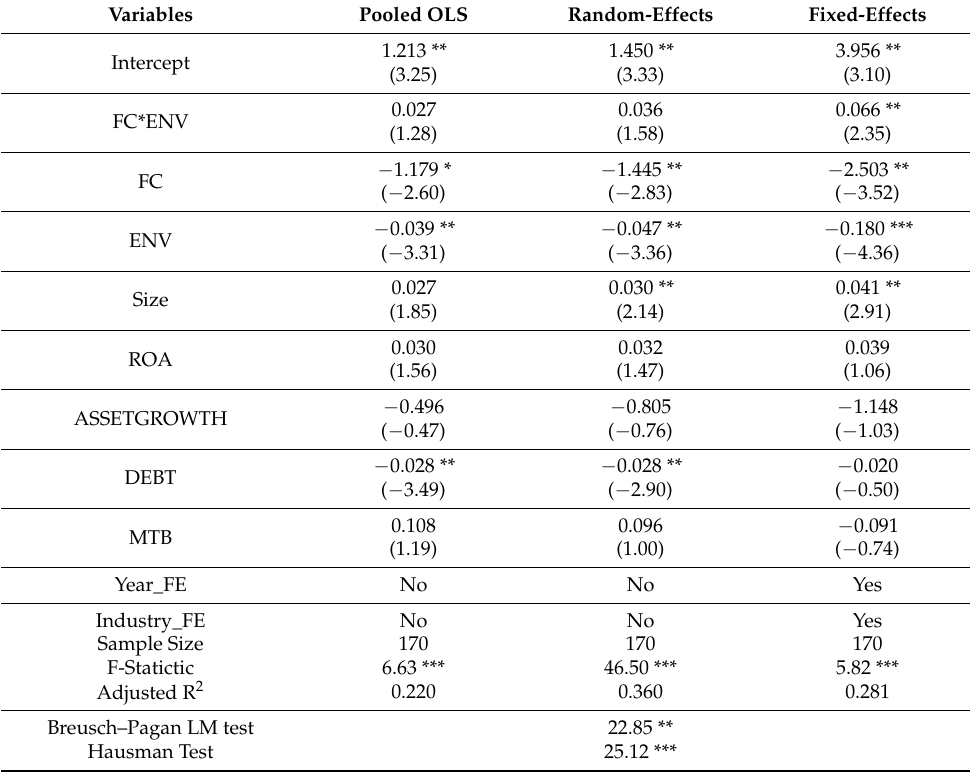
Table 5. The moderating impact of financial constraints on the association between environmental disclosures and stock